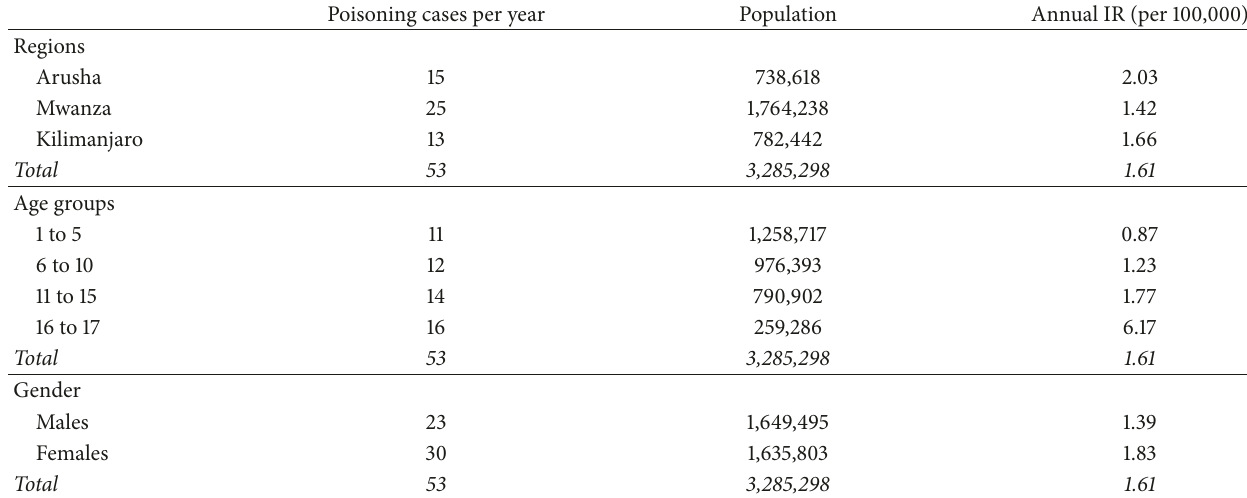
Table 3: Incidence rate, mortality rate, and case fatality rate for APP for children in